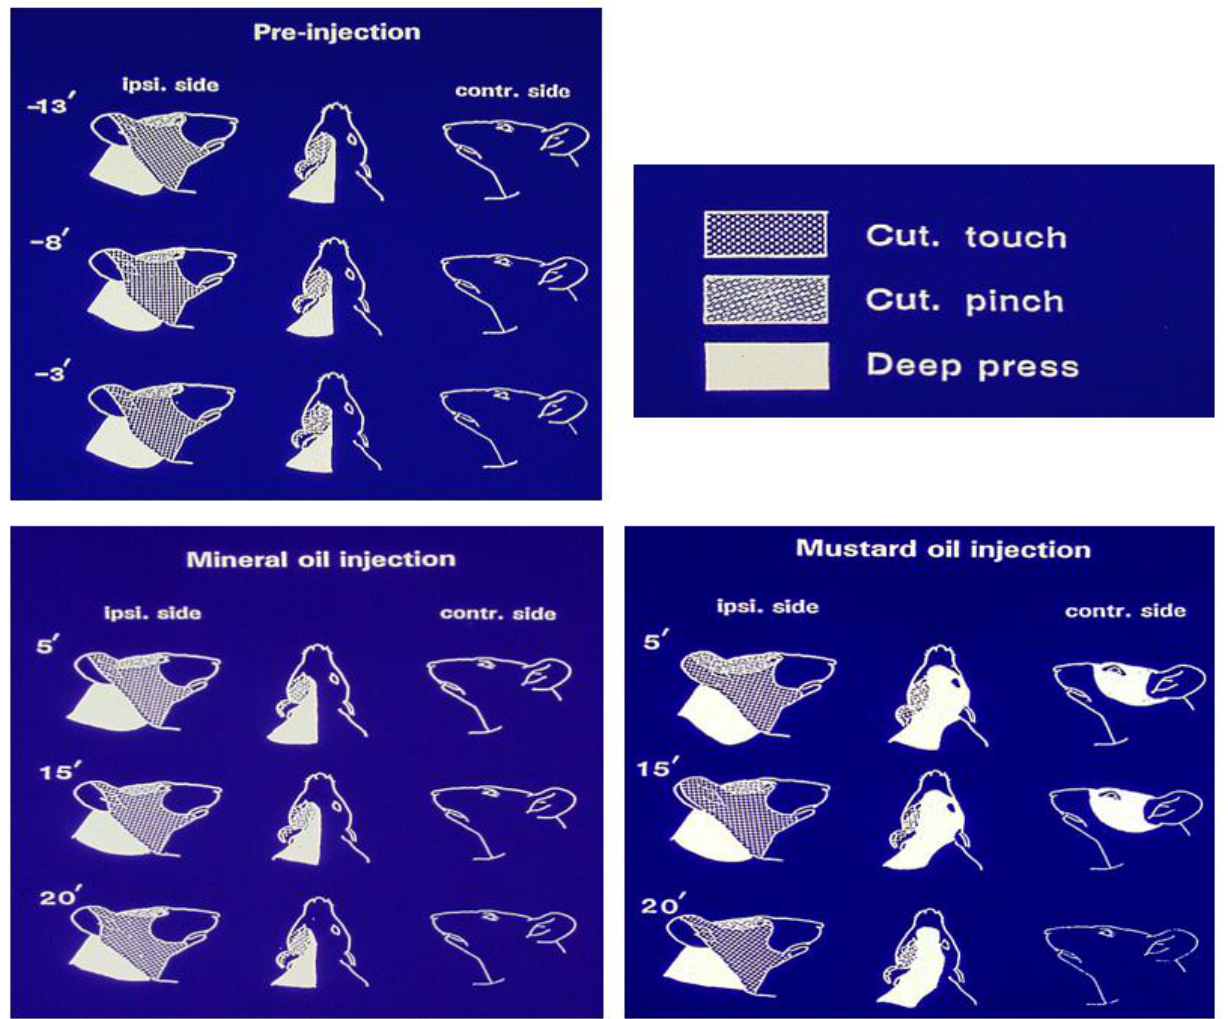
Figure 3. Features of a nociceptive neuron recorded in the rat medullary dorsal horn that exhibited extensive mechanoreceptive field expansion as a reflection of trigeminal central sensitization induced by intramuscular injection of the inflammatory irritant mustard oil. The neuron was a wide dynamic range neuron since it could be activated by tactile stimulation of the cutaneous periorbital area as well as by pinch stimulation of the posterior facial skin and by heavy pressure applied to posterior cranial and cervical tissues. The figurines show that in the control condition (pre-injection), the mechanoreceptive field was limited to the ipsilateral side and was stable for several minutes, and also did not change over a 20-min period following injection of vehicle control (mineral oil) into the tongue musculature. However, note that within 5 min after the injection of the inflammatory irritant mustard oil into the tongue, the mechanoreceptive field had expanded to encompass the ipsilateral ear as well as contralateral facial and cervical areas. The expanded mechanoreceptive field was maintained for at least another 10 min before returning towards pre-injection features by 20 min. Based on data from Yu et al. [89].